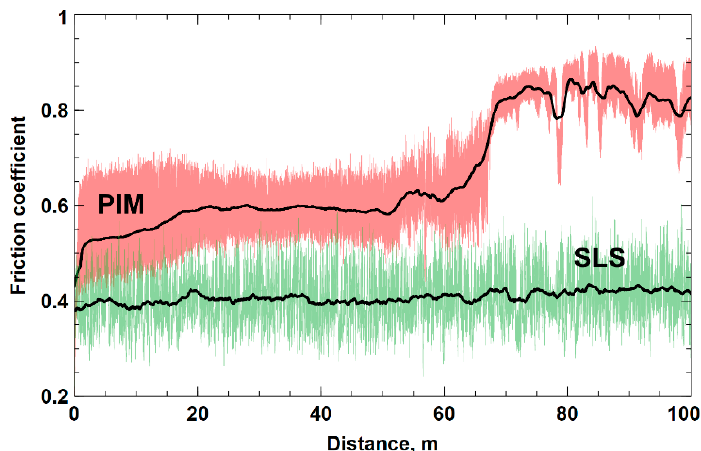
Figure 11. The friction coefficient during ball-on-disk wear testing.